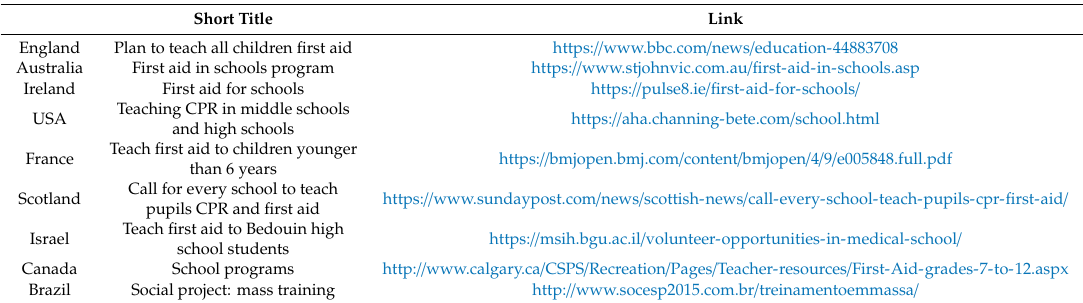
Table 8. Resources about promotion and education of first aid initiatives in di ff erent countries in the school context (Google’s